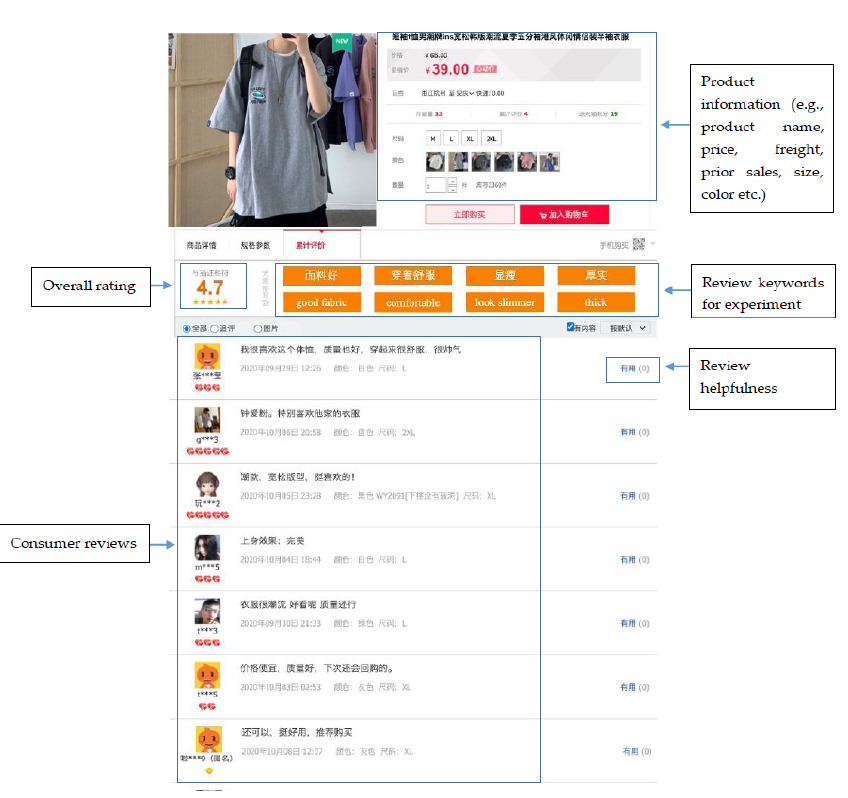
Figure A1. An example of experiment design (adapted from Taobao website, source: https://www.taobao.com/) (accessed on 10 December 2020).